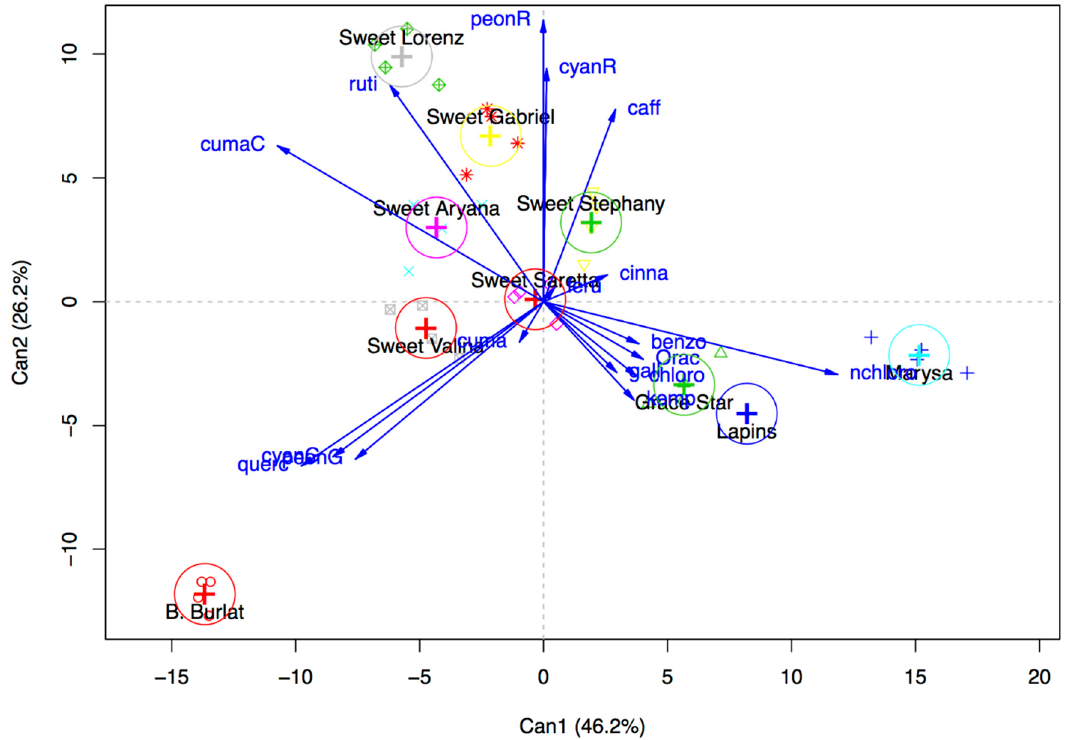
Figure 5. Canonical discriminant analysis of the AA (ORAC) and anthocyanin, phenolic acid, and flavonol contents of sweet cherry extracts. Can1 = canonical component 1; Can2 = canonical component 2.